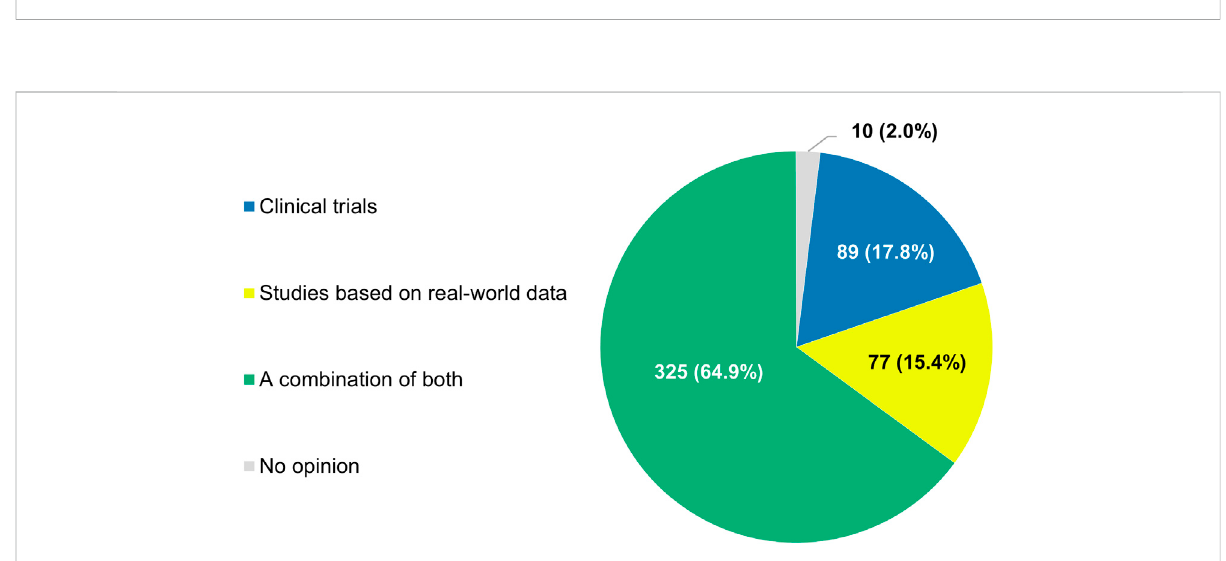
FIGURE 9 The role that participants thought real-world evidence should play in the decision-making process of (A) regulators and (B) payers, and (C) the role it currently plays in their own decision-making, as compared with evidence derived from randomized controlled trials. The percentages shown foreachitemmaynotadduptoexactly100%duetorounding.Thenumbersinbracketsindicatetheabsolutenumberofrespondentscorresponding with each